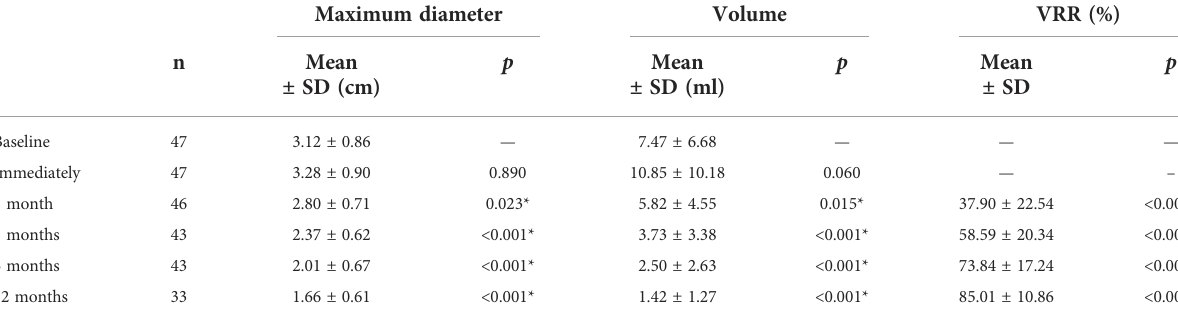
TABLE 3 The maximum diameter, volume, and VRR changes of thyroid nodules after MWA.